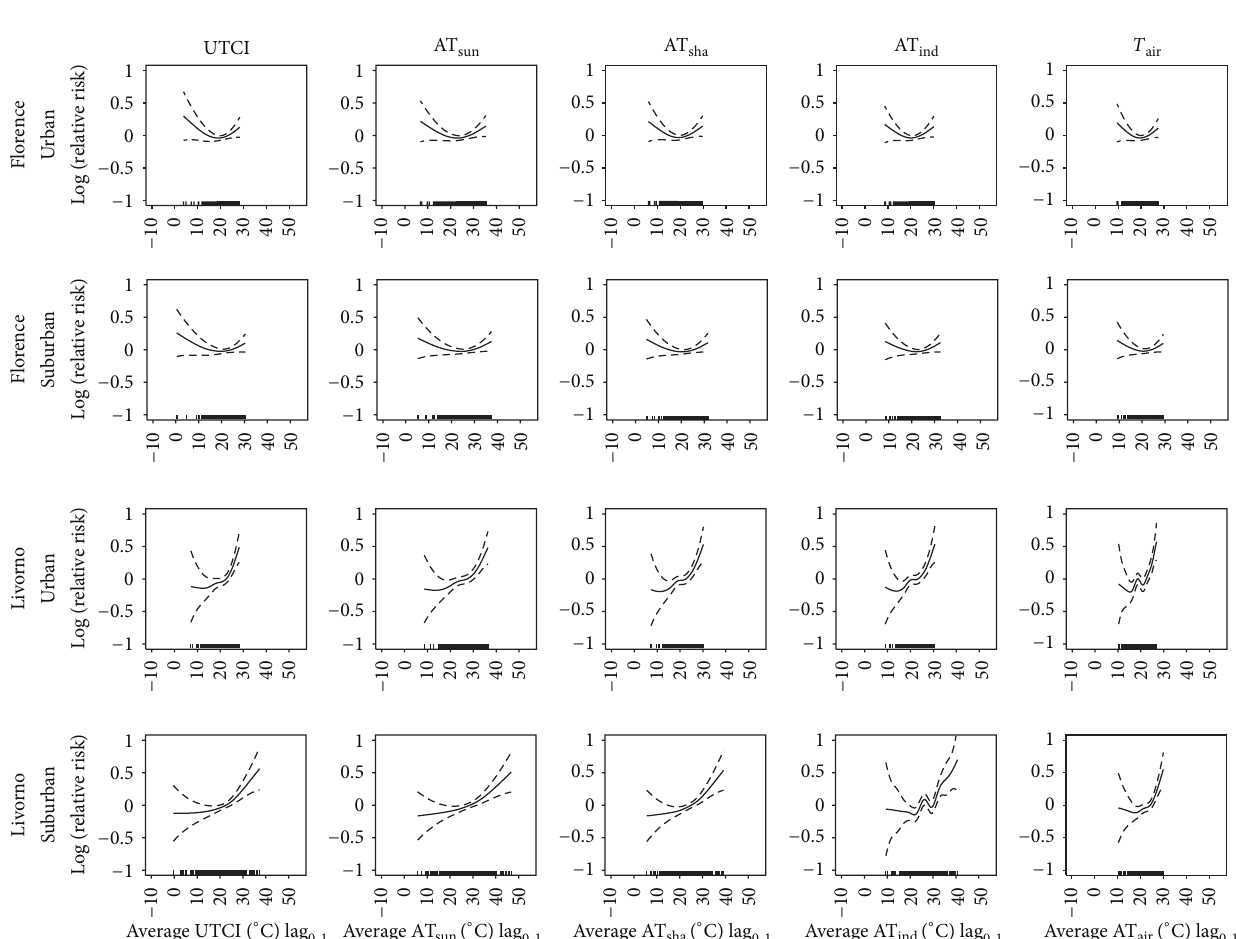
) ( ∘ C) and mortality of the very elderly (subjects ≥ 75 years of age) in Figure 1: Relationships between daily average thermal predictors ( lag 0 - 1 an inland city (Florence) and coastal-plain city (Livorno). Relationships estimated by using urban and suburban meteorological data for the period 2006–2008 (May–October). UTCI: Universal Thermal Climate Index; AT sun : apparent temperature assessed outdoors also taking the solar radiation contribution into account; AT sha : apparent temperature assessed outdoors in the shade; AT ind : apparent temperature assessed : environmental temperature. Analyses were controlled for air pollution concentrations, daylight hours, year, day of in indoor conditions; 𝑇 air the week, public holidays, and summer population